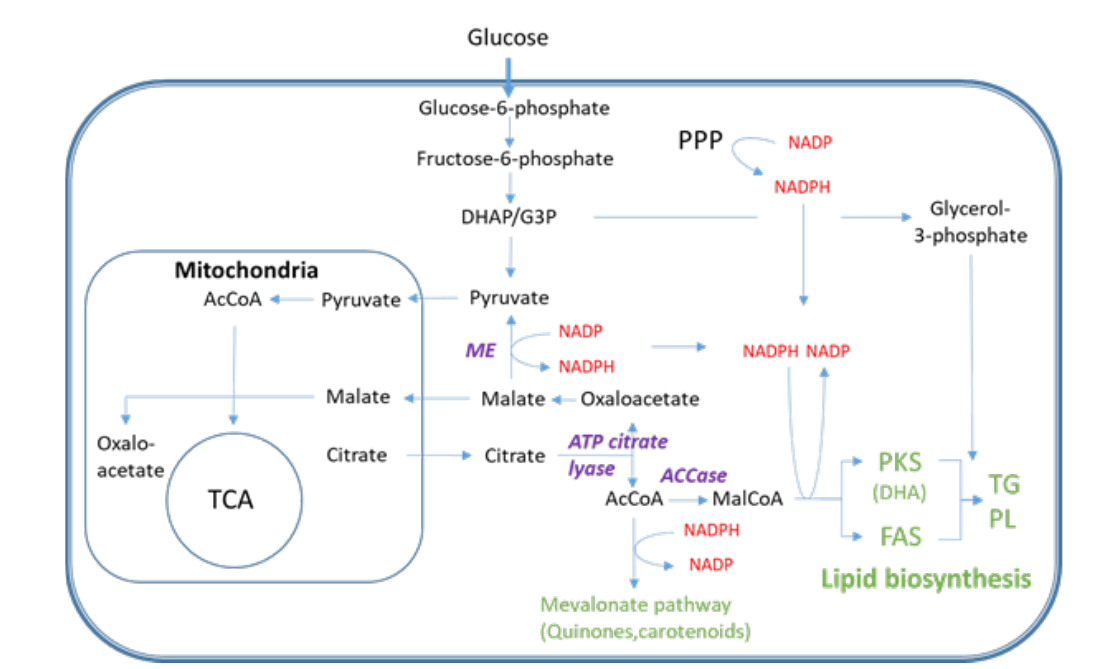
Figure 1. Overview of the metabolic pathway for DHA (PKS) and saturated fatty acid (FAS) biosynthesis with focus on carbon precursor and NADPH formation. Abbreviations not explained in the text: AcCoA: acetyl-CoA, MalCoA: malonyl-CoA, ACCase: AcCoA carboxylase, DHAP: dihydroxyacetone phosphate, G3P: glyceraldehyde 3-phosphate, PPP: pentose phosphate pathway, TCA: tricarboxylic acid cycle, PL: phospholipid.